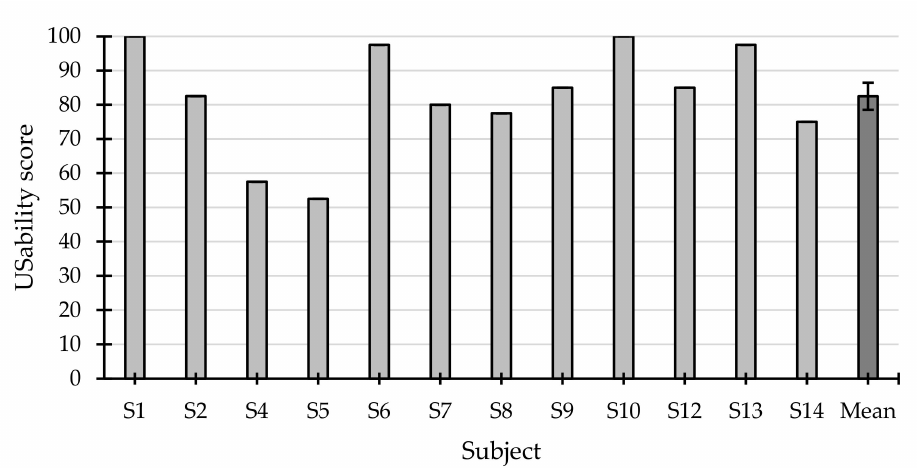
Figure 6. Overall usability score of each subject, measured with the system usability scale, and the average ( ± standard error).